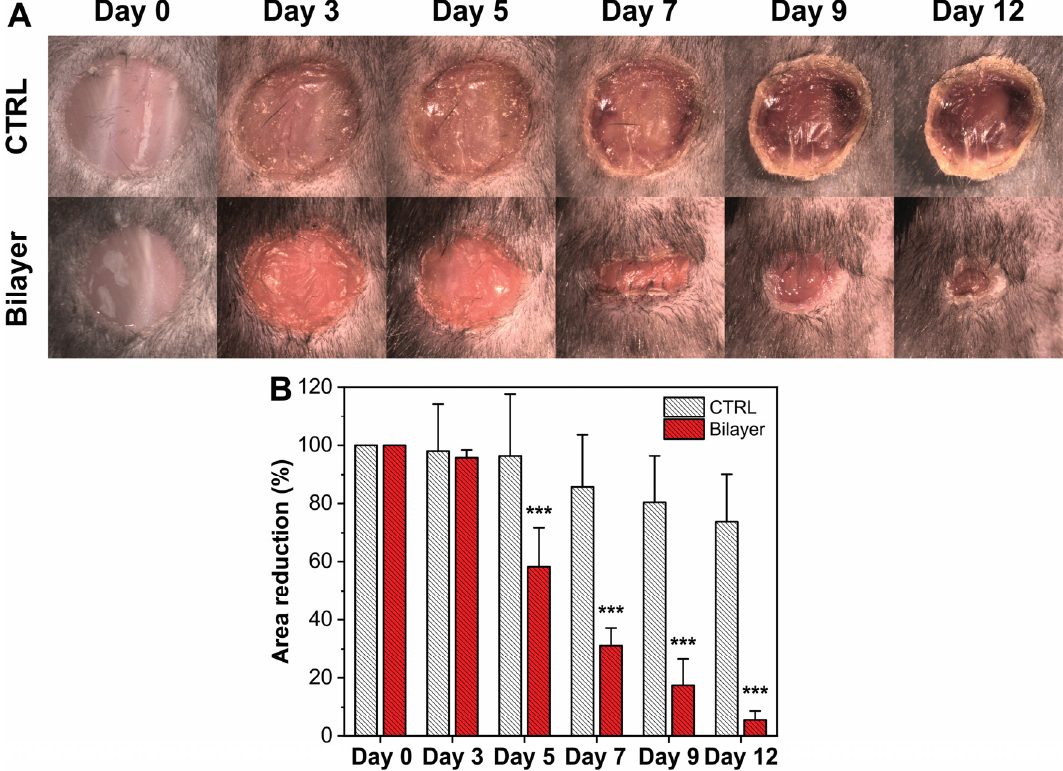
Figure 7. ( A ), Representative photographs of the skin of diabetic mice wound healing at different time points (day 0, day 3, day 5, day 7, day 9, and day 12): untreated (no dressing) and bilayer dressing treated wounds are shown. ( B ), Time-course (days) of wound healing in mice untreated (white bars) and treated with the bilayer (red bars). *** p <0.001, compared to untreated mice.